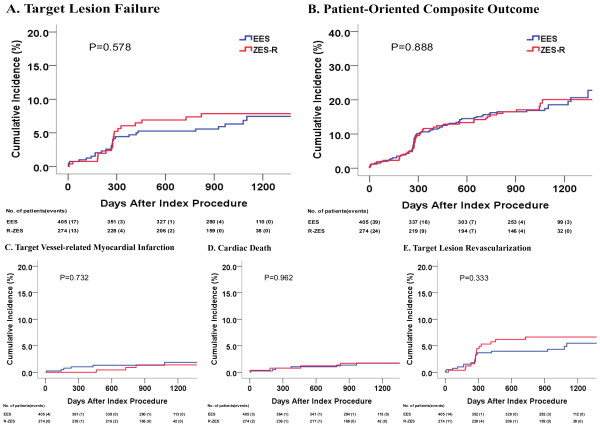
Survival analysis for target lesion failure and patient-oriented composite outcome up to 3 years of follow-up. A) Target lesion failure. B) Patient-oriented composite outcome. C) Target vessel myocardial infarction D) Cardiac death E) Target lesion revascularization. Target lesion failure defined as a composite of cardiac death, myocardial infarction (not clearly attributed to a nontarget vessel), or clinically indicated target lesion revascularization by percutaneous or surgical methods. Patient-oriented composite outcome included all-cause mortality, any myocardial infarction (includes nontarget vessel territory), and any revascularization (includes all target and nontarget vessel, regardless of percutaneous or surgical methods). Log rank p value or Breslow p value were presented. Abbreviations: EES, everolimus-eluting stent; R-ZES, Resolute zotarolimus eluting-stent.